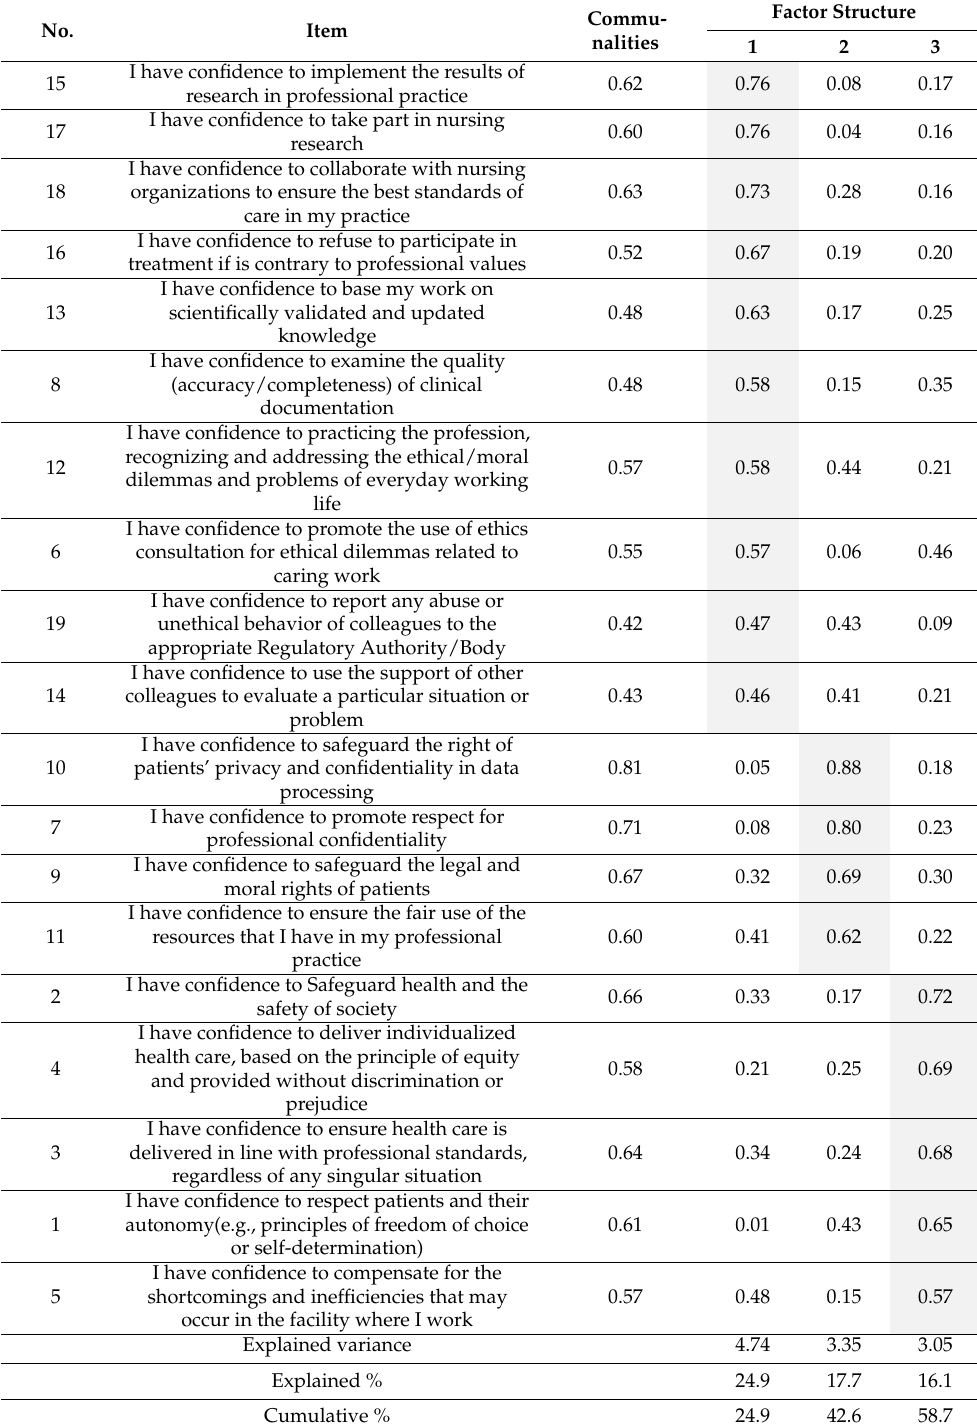
Table 1. Exploratory Factor Analysis of K-NPSE (N =